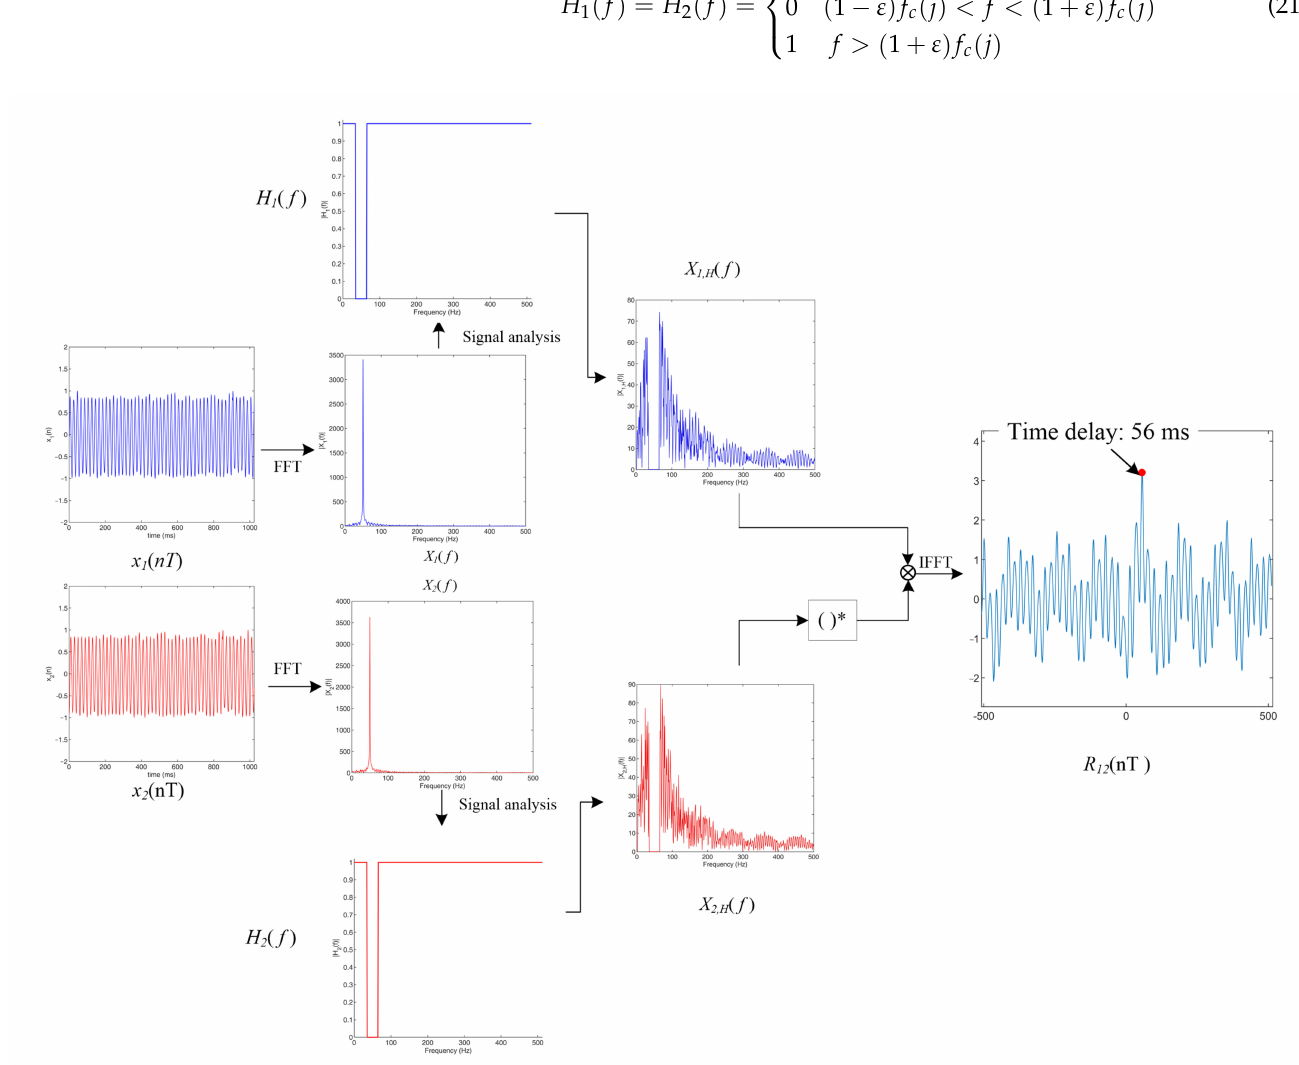
Figure 5. New adaptive GCC method for the signals in Figure 3 (the filter range coefficient ε = 0.05). With the obtained band-stop filters, the remaining steps are the same as the AGCC method that was introduced above, i.e., obtain the spectra of the filtered signals (Equations (3) and (4)), obtain the mutual power spectral density of the filtered signals (Equation (5)), obtain the cross-correlation function (Equations (6)) and find the peak position of the cross-correlation function to determine the time delay of the two input